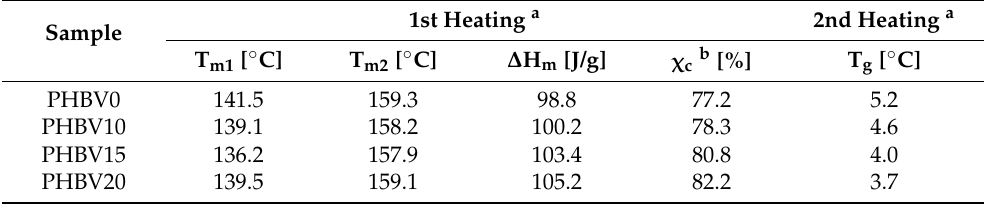
Table 4. Thermal properties and crystallinity of the electrospun PHBV mat after various times of degradation with LiBH 4